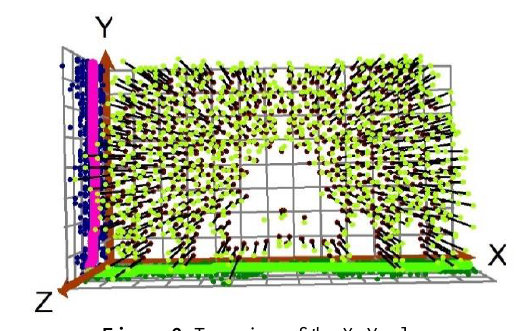
Figure 9 . Top view of the X-Y plane